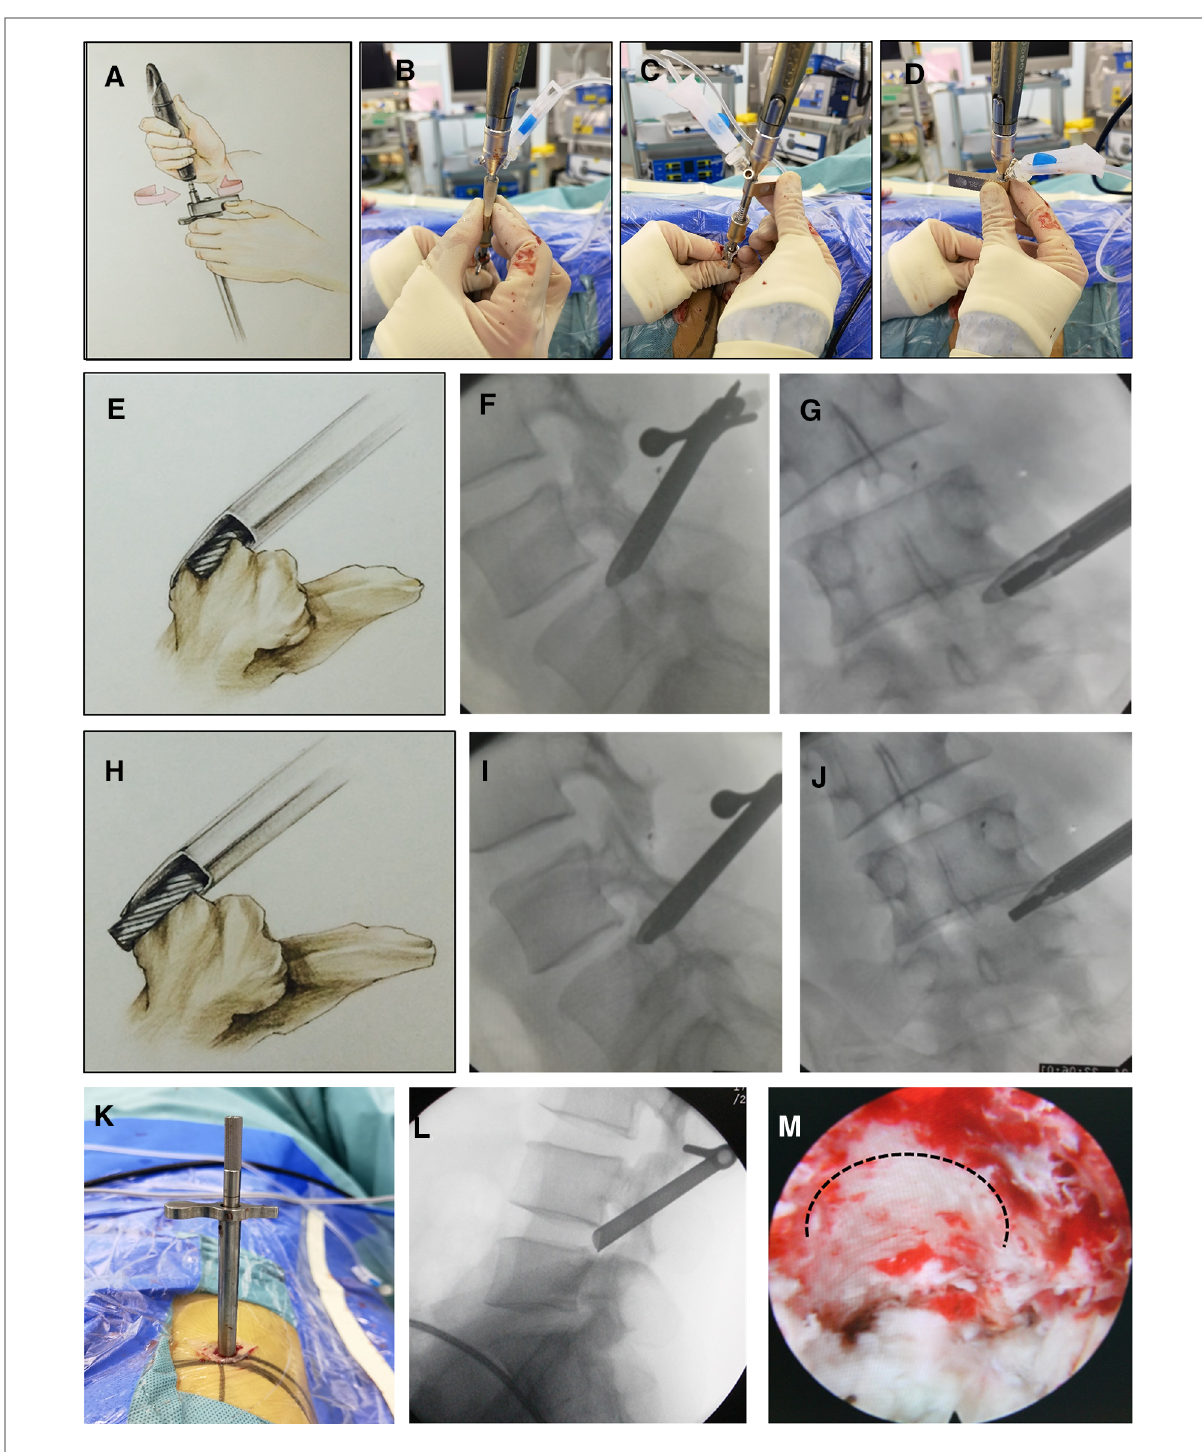
FIGURE 2 The surgical procedure of modi fi ed lumbar foraminoplasty using a power-aided reciprocating burr (L4/5). ( A-D ): Due to the design of the decentered cylindrical burr head, the burr was rotated to approximately 180° to remove the bone of the superior articular process and enlarge the intervertebral foramen. ( E-J ): The control apparatus, which has a graduated scale at the tail end of the burr stem, allows precise control of the depth of resection of the superior articular process cortex without damaging the nerve roots. ( K ): The working cannula was inserted along the pencil-like guide rod. ( L ): The tip of the working cannula should be fi xed on the posterior rim of the upper endplate of the distal vertebra in the lateral fl uoroscopic view. ( M ): The bone wall on the superior articular process was smooth and regular; the heat generated by the drill reduced cancellous bone